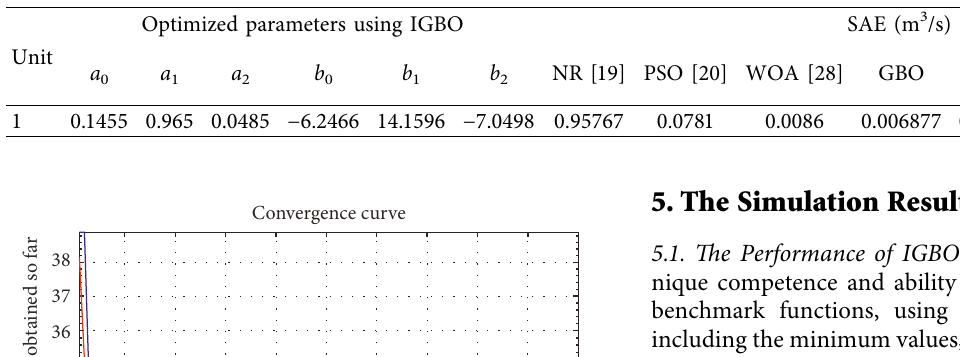
Table 14: Optimized parameters and SAE of model 9.